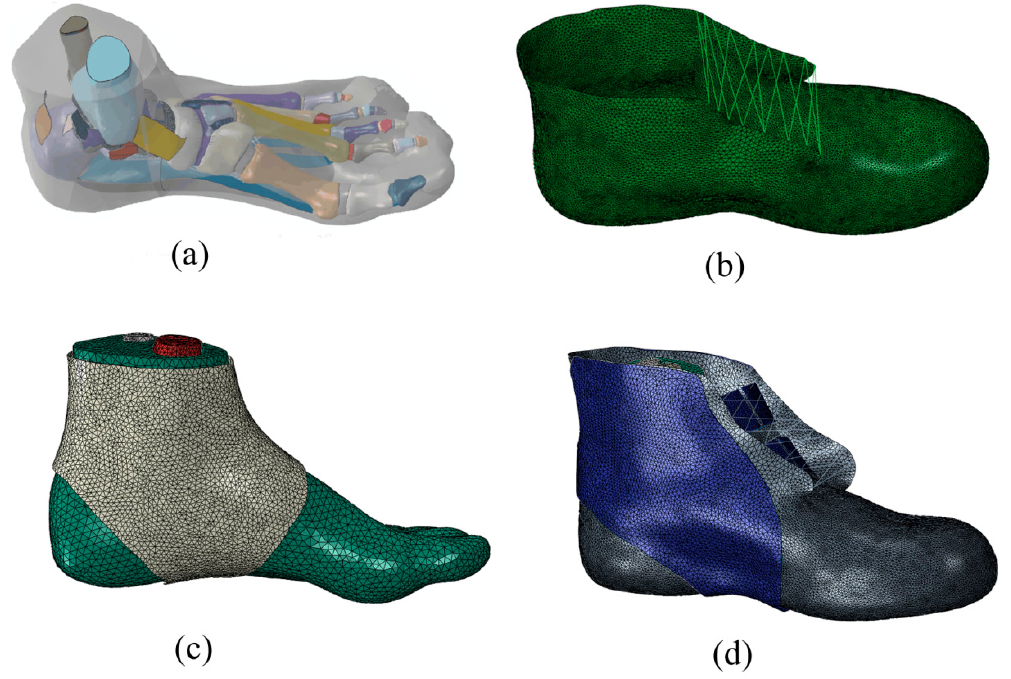
Figure 3. FE model: ( a ) foot structure; ( b ) boot; ( c ) foot and the elastic ankle brace; and ( d ) foot, boot and the outside ankle brace.